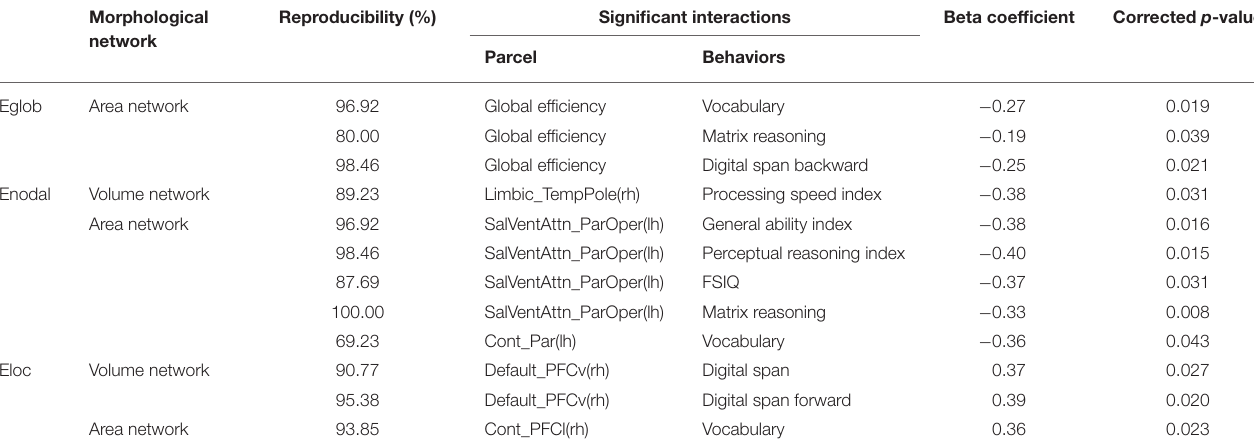
TABLE 4 | The significant age × network efficiency interactions in cognitive